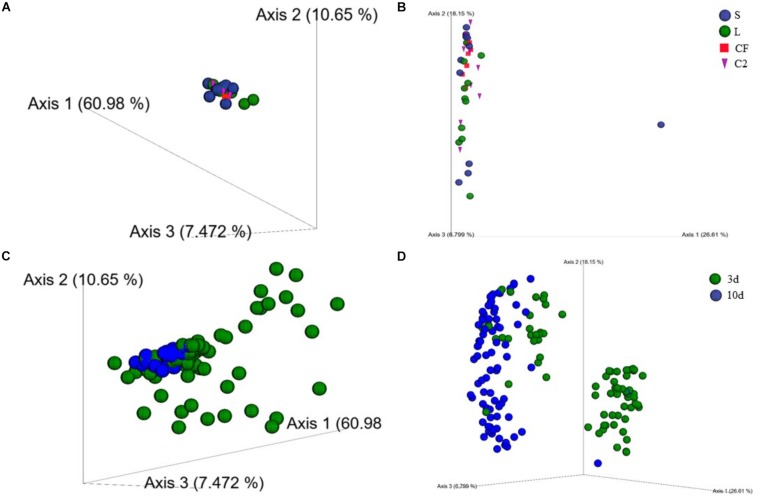
(A) Beta-diversity of microbial communities in lower ileum of broilers treated with either saline (S), LAB-probiotic (L), Citrobacter freundii (CF) or Citrobacter spp. (C2) at 10 days of age based on weighted UniFrac distances. (B) Principal coordinate analyses (PCoA) plot is showing the beta-diversity clustering pattern of samples in lower ileum at 10 days of age derived from unweighted UniFrac (P < 0.05, PERMANOVA). (C) Weighted and (D) Unweighted UniFrac-based PCoA plots reveal a clustering by age in upper and lower ileum (P < 0.05, PERMANOVA).